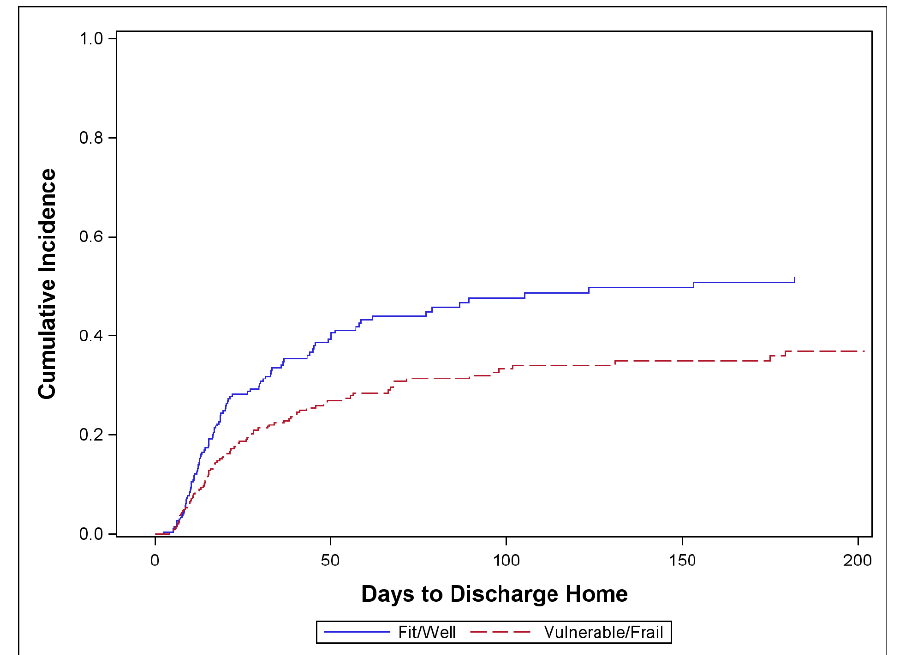
Figure 3. Cumulative incidence of discharge home comparing frail versus non-frail patients when Clinical Frailty Scale (CFS) is dichotomized as vulnerable/frail (CFS ≥ 4) vs. fit/well (CFS ≤ 3). All surgical ICU patients, n = 232 ( p = 0.007); 82 patients discharged home, 74 competing events, and 76 censored. One additional patient was excluded due to unknown CFS